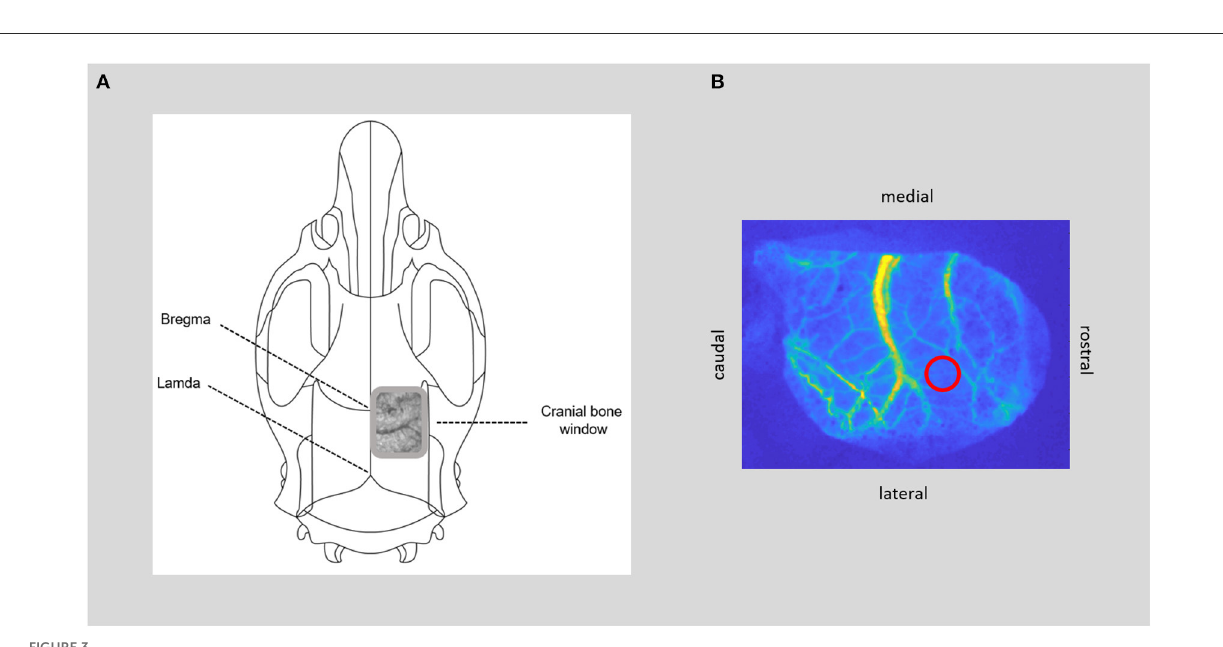
FIGURE3 CBF measurement. (A) Positioning of the bone window over the somatosensory cortex, with thinned bone and visible cerebral vessels. (B) Image of cerebral blood flow calculated from raw laser speckle images with the region of interest within the microcirculation (red circle) for time course analysis of cerebral blood